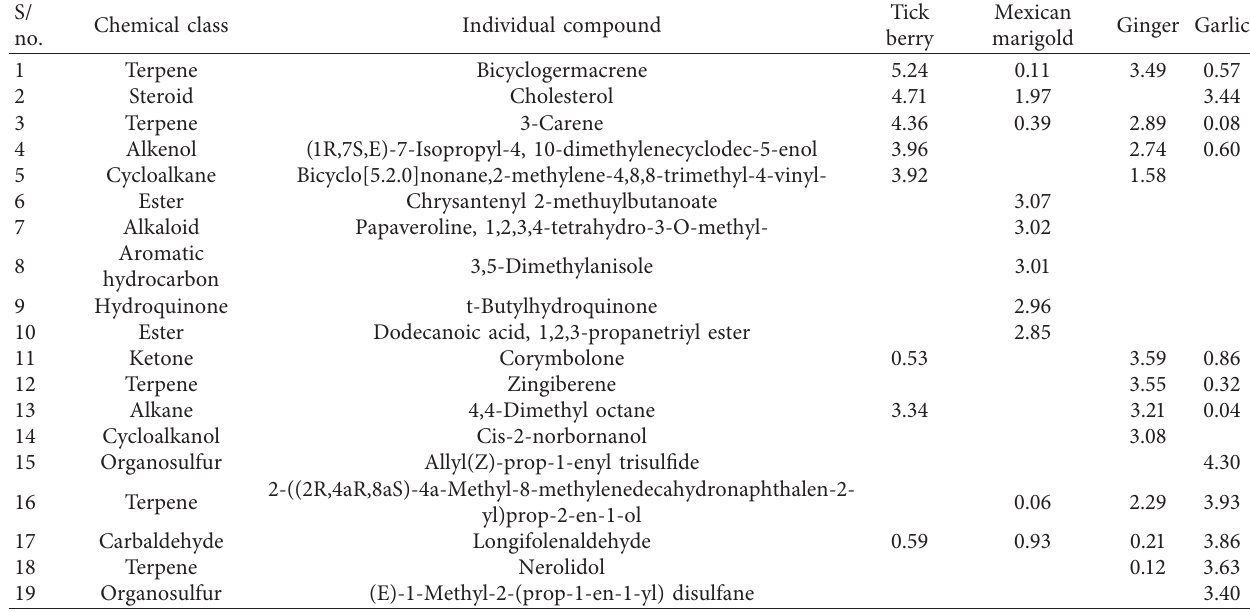
Table 2: Most abundant compounds in the major classes of volatile